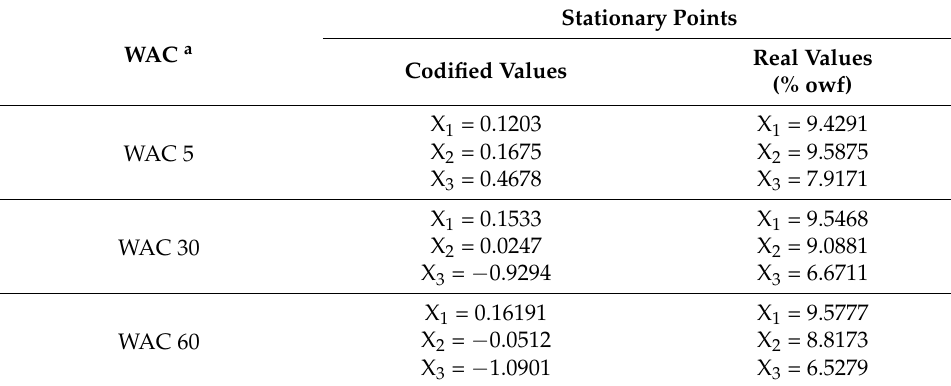
Table 5. Stationary points for water absorption